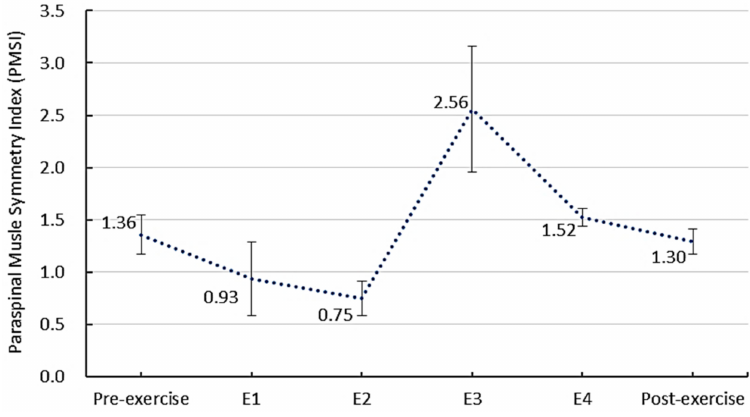
Figure 2. The PMSI before, during and after the Schroth exercise ( n = 9).